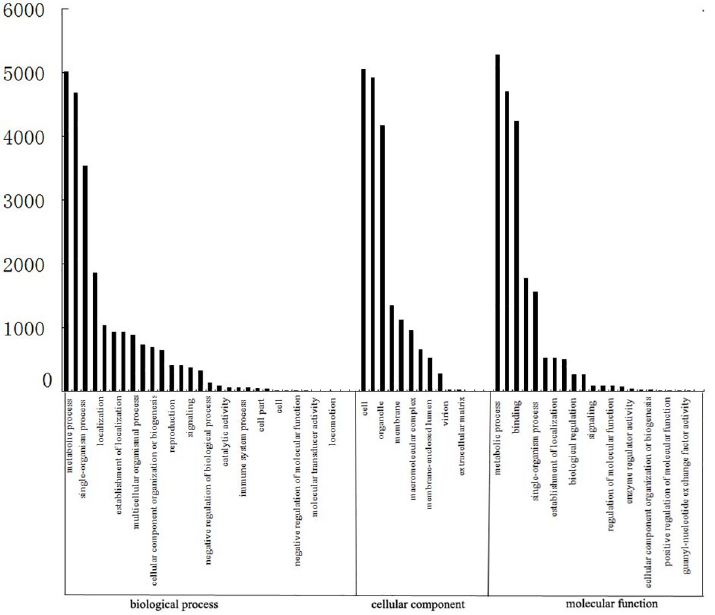
Fig 4. Functional annotation of assembled unigenes based on Gene Ontology (GO) categorization. The results are summarized in three main categories: biological process, cellular component and molecular function.